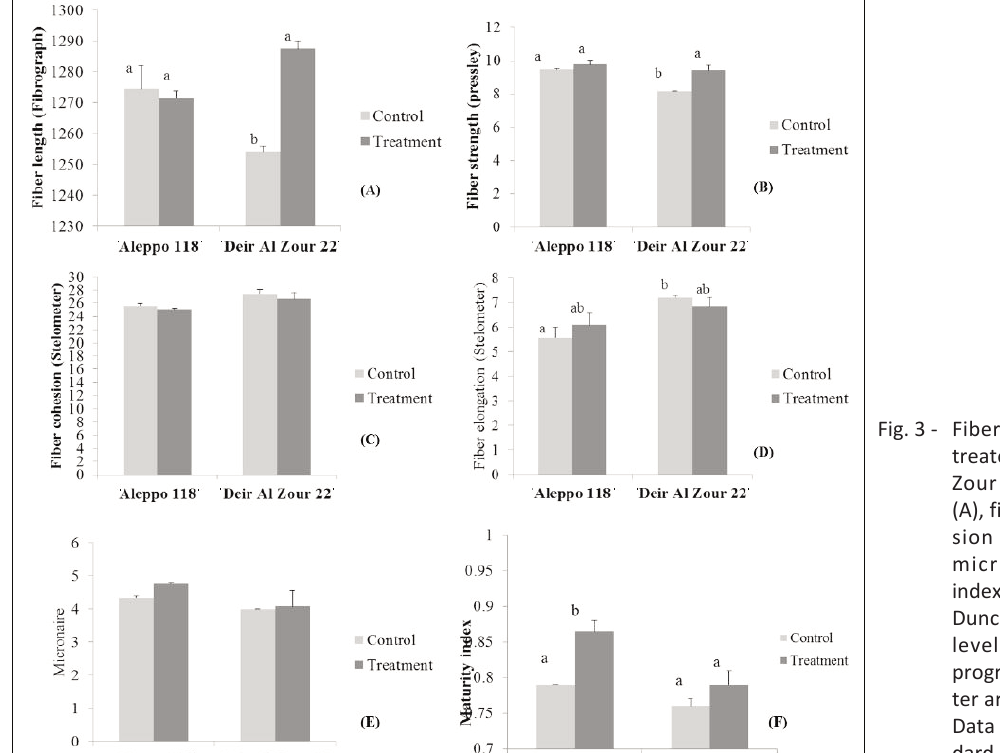
Fig. 3 - Fiber properties of control and treated Aleppo 118 and Deir Al- Zour 22 cultivars. Fiber length (A), fiber strength (B), fiber cohe- sion (C), fiber elongation (D), micronaire (E), and maturity index (F). Data were subjected to Duncan’s test with a confidence level of 95% using STATISTICA program. Columns sharing a let- ter are not significantly different. Data represent means and stan- dard error of three